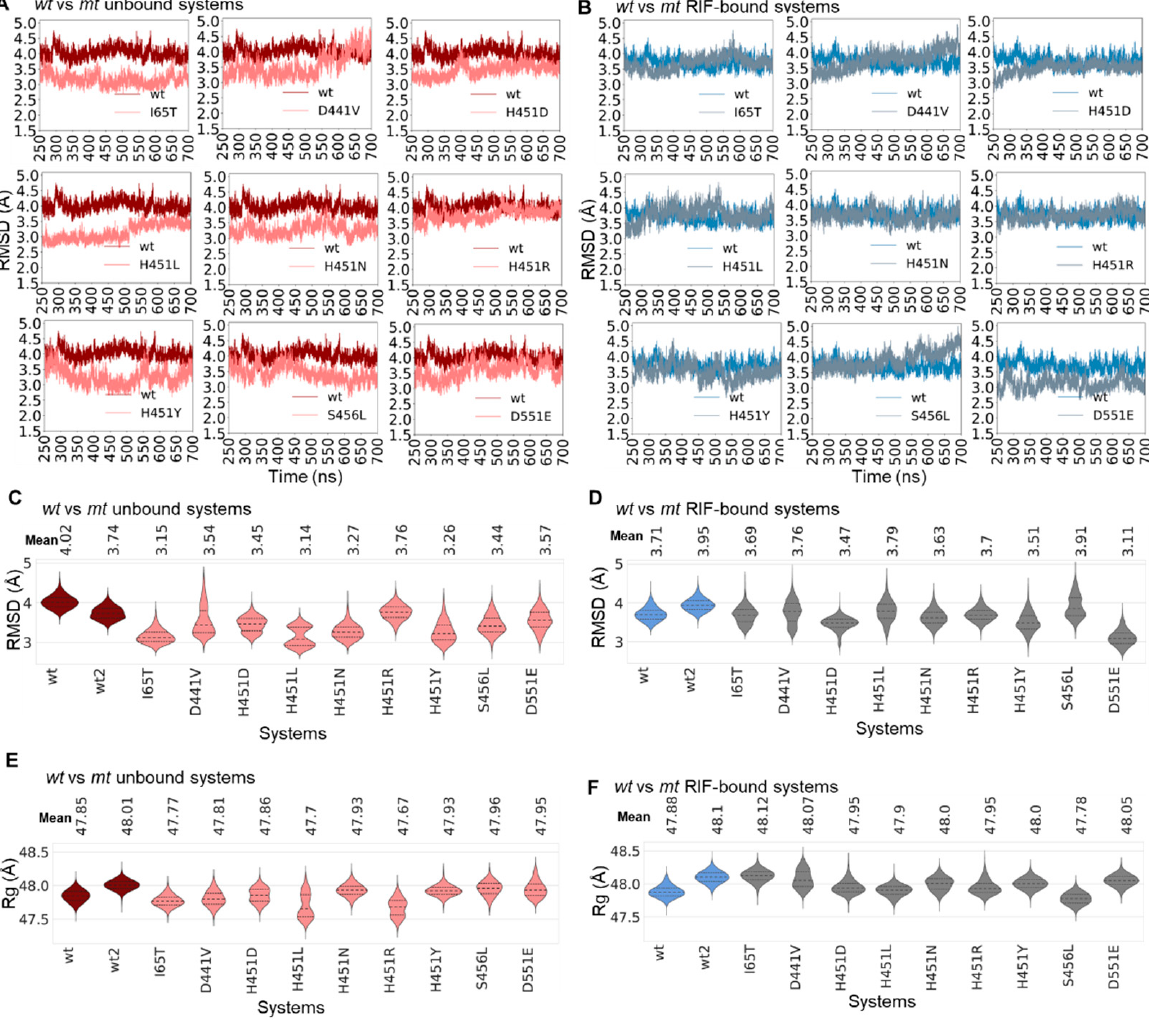
Figure 2. Structural analysis of Mtb -RNAP dynamics due to mutation and/or RIF binding. The line plots represent the captured C α -RMSDs (with reference to their initial structures) for ( A ) RIF-unbound and ( B ) bound wt (unbound, maroon; RIF-bound, blue) and mt (unbound, orange; RIF-bound, pink) Mtb -RNAP proteins. C α -RMSD distribution violin plots are shown for the ( C ) unbound and ( D ) RIF-bound wt s and mt s. The mean C α -RMSD values are indicated above the plots, while the dotted lines on the violins represent the 25th, 50th and 75th quartiles. Similarly ordered Rg distribution violins are also shown for the ( E ) unbound and ( F ) RIF-bound systems. The same coloring scheme used in the line plots is used in the violins.